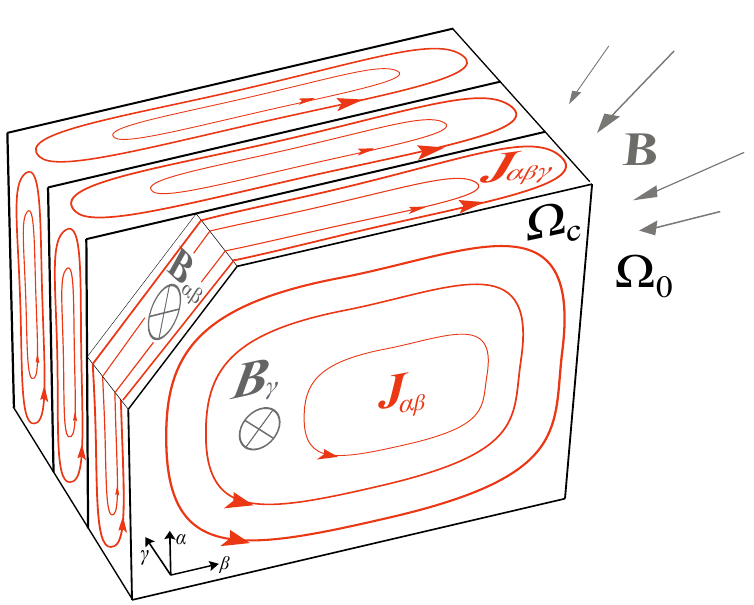
Figure 3. Representation of relevant fields and eddy currents in a simple laminated